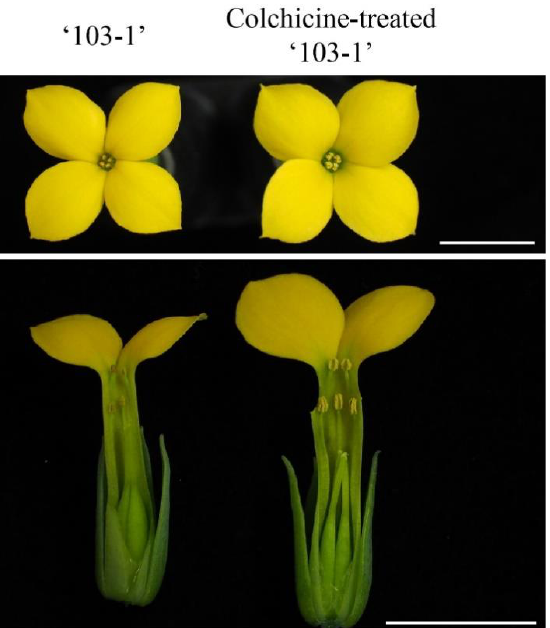
Figure 3. Pollen release from anthers of ‘103-1’ ( Kalanchoe garambiensis ‘Type 1’× K. nyikae ) was rescued by colchicine treatment. Control ( left ) shows abnormal pollen generation and 10,000 mg · L − 1 colchicine-treated plant ( right ) shows normal pollen release from the anther. The upper panel shows top views of flowers, the bottom panel shows side views of flowers. Scale bar = 10 mm.